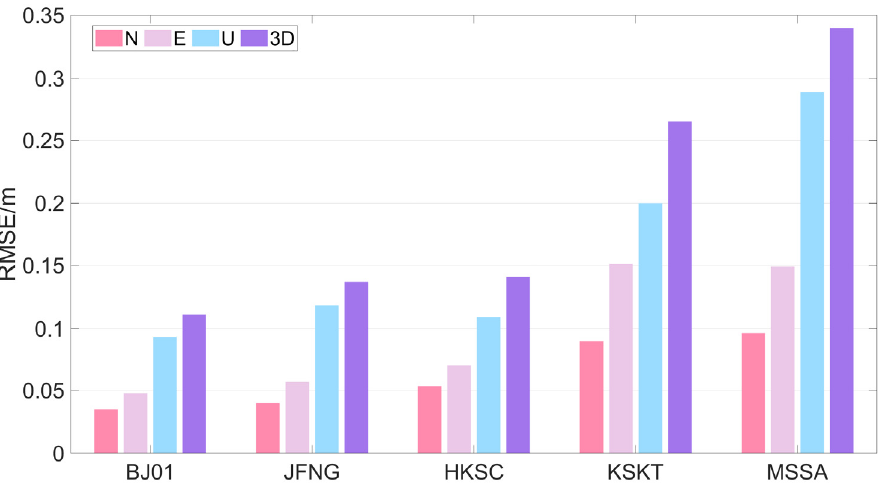
Figure 12. Mean RMSE of the real-time PPP-B2b positioning errors of the simulated kinematic PPP- B2b solutions for the five stations in the north, east, and up directions, and 3D coordinates, during DOY 355–361 in 2022.